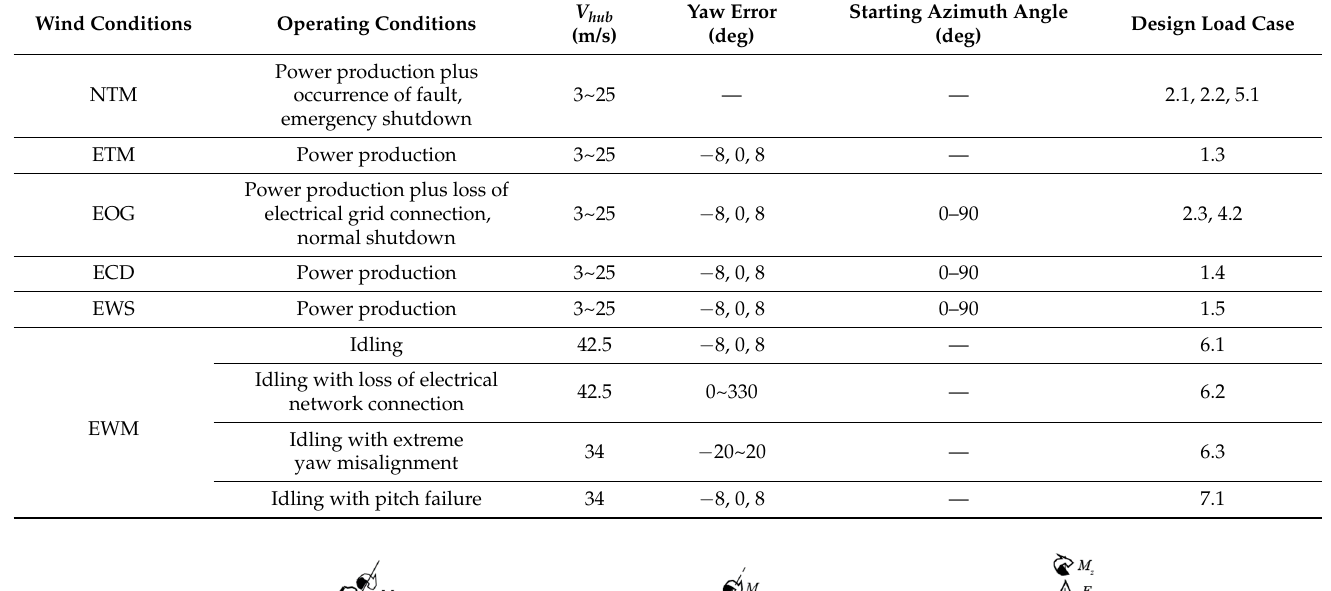
Table 1. Design load cases.